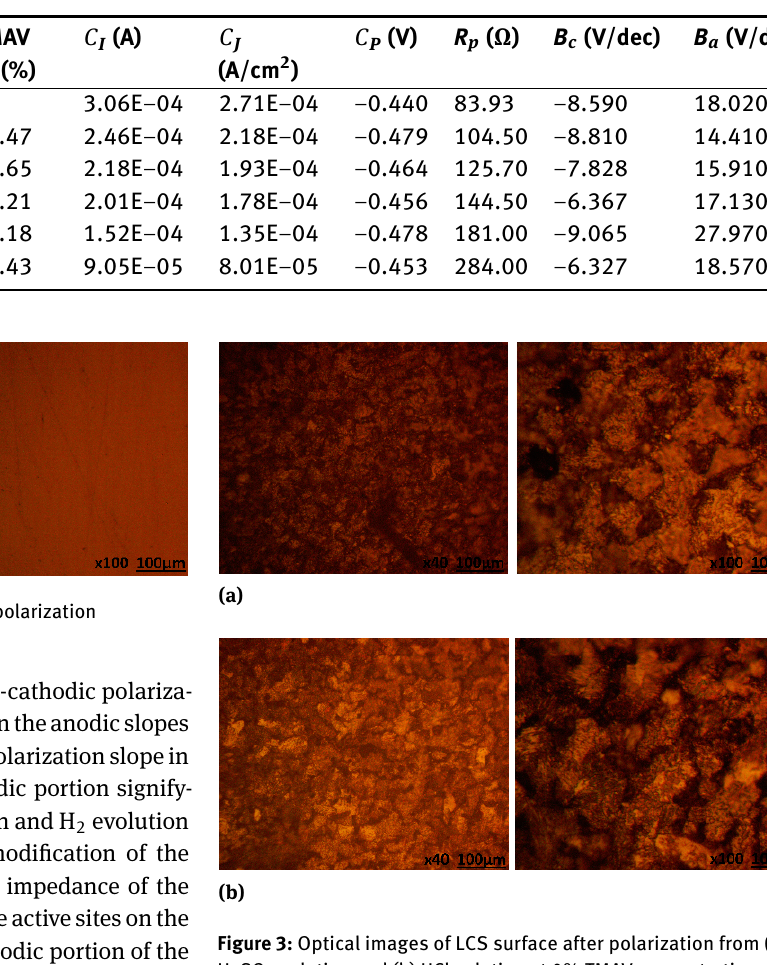
ficiency of 80.85% (5% TMAV concentration). The corre- sponding image at this concentration (Figure 4(a)) show slightly improved morphology. The mild surface deteriora- tion is due to initial adsorption of SO 2− ions before electro- 4 static attraction of protonated TMAV molecules onto the steel